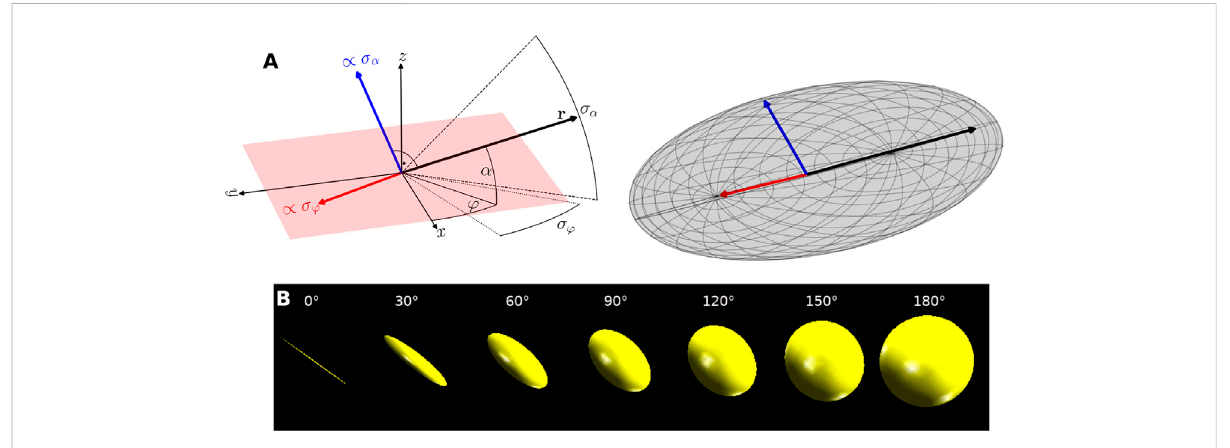
FIGURE 5 Visualizationoforientationuncertaintybyellipsoids. (A) ellipsoidconstruction.Left:asketchofthemaximumlikelihood fi berorientation r given by in-plane angle φ and out-of-plane angle α . Right: resulting orientation uncertainty ellipsoid. The main axis is given by r while the semi-axes are scaledbytheangular credibleintervals σ α and σ φ . Fiberparameters: α = φ = 30 ° , σ α =40 ° , σ φ =30 ° . (B) Ellipsoids forvaryingorientationuncertainty.For small orientation uncertainty the ellipsoid appears linear (left, σ α = σ φ = 0 ° ). With increasing uncertainty the representation becomes more spherical (right, σ α = σ φ = 180 ° ).